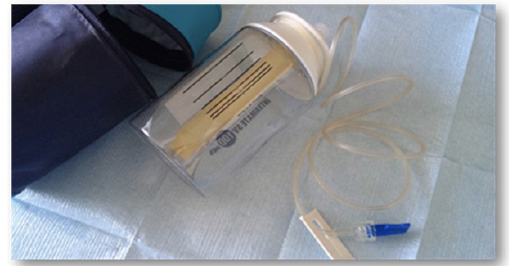
Figure 1. LV10® pump from Baxter